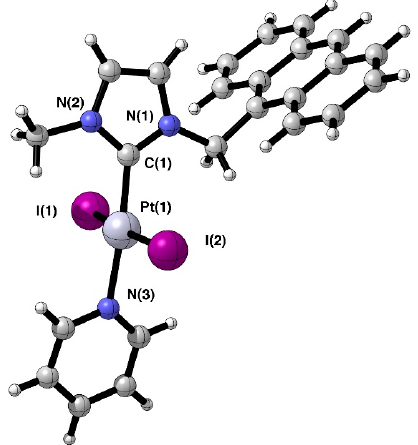
Figure 3. Molecular structure of the platinum complex 1 . Selected bond lengths (Å) and angles (°):